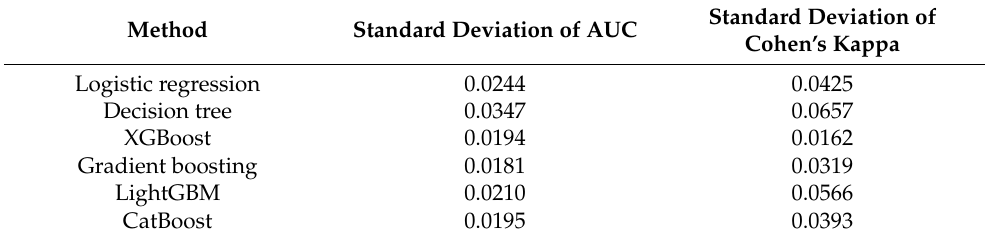
Table 15. Standard deviation value of AUC and Cohen’s kappa coefficients for the applied supervised learning methods after a 10-fold splitting of the sample into a training set and a test set and running the specified